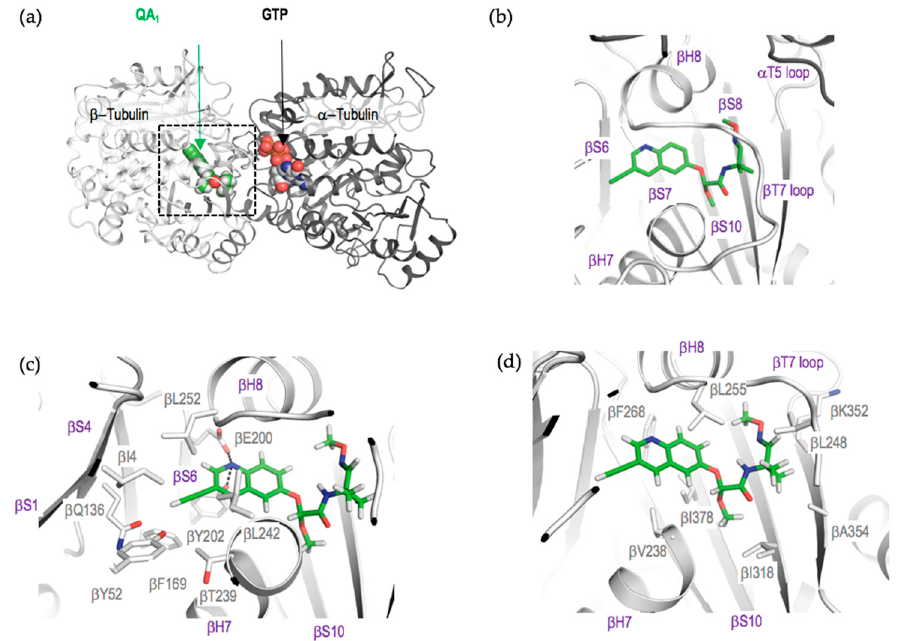
Figure 5. QA 1 binds at the colchicine site of tubulin. ( a ) Overall view of the tubulin-QA 1 complex. QA 1 is displayed as green spheres; ( b ) A close up view of the region highlighted with a dashed rectangle in ( a ) and showing the QA 1 binding site. QA 1 is displayed as green sticks. Major secondary structure elements are labelled; ( c , d ) Interacting residues of β - tubulin with QA 1 . Oxygen and nitrogen atoms are displayed in red and blue, respectively.